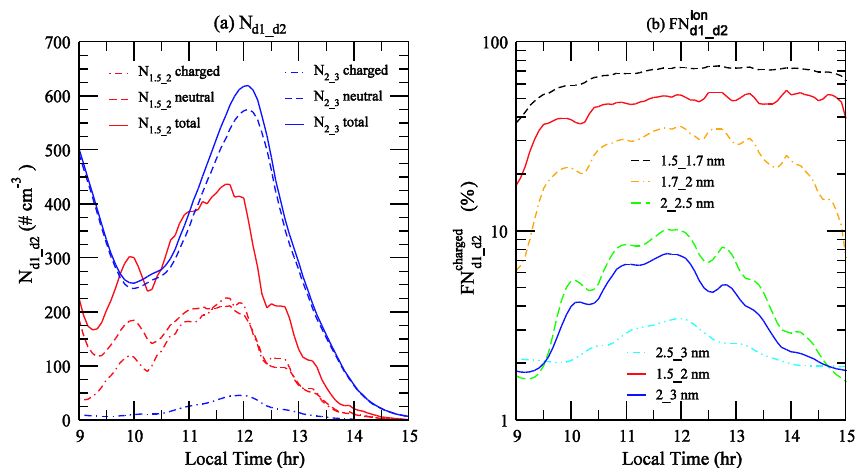
Figure 3. Fig. 3. Corresponding to Fig. 2, IMN simulations for the nucleation event observed in Hyyti¨al¨a on 27 April 2005, showing: (a) the number concentrations of neutral, charged, and total particles ( N neutral charged fraction of the total number of particles ( FN ion ion = J for J 0 , FJ ion d d